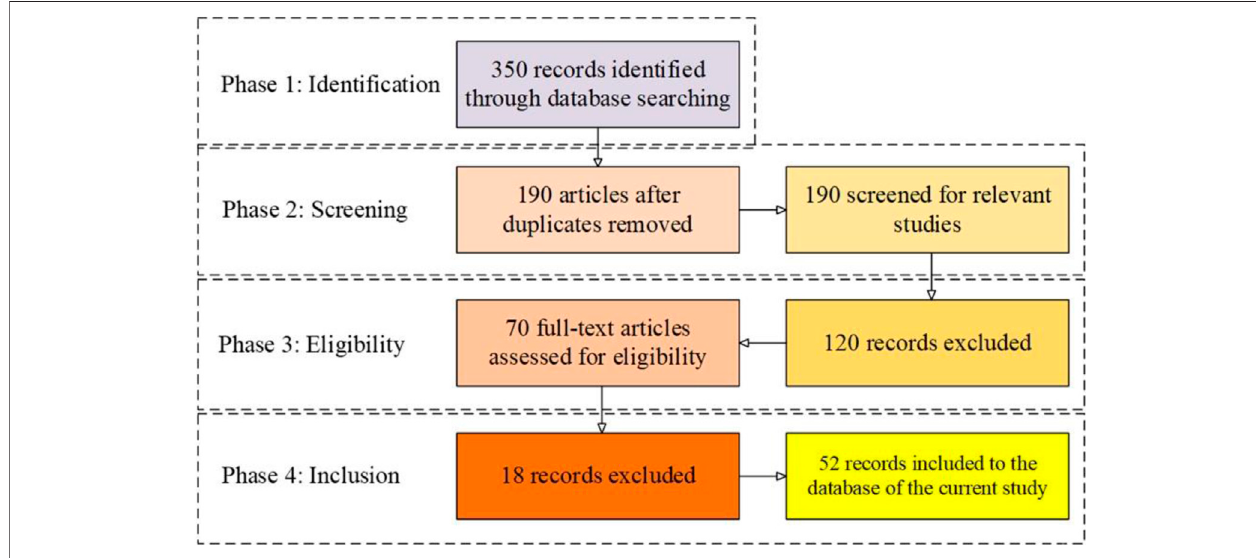
FIGURE 2 | Procedure of the PRISMA technique for the reviewing process.